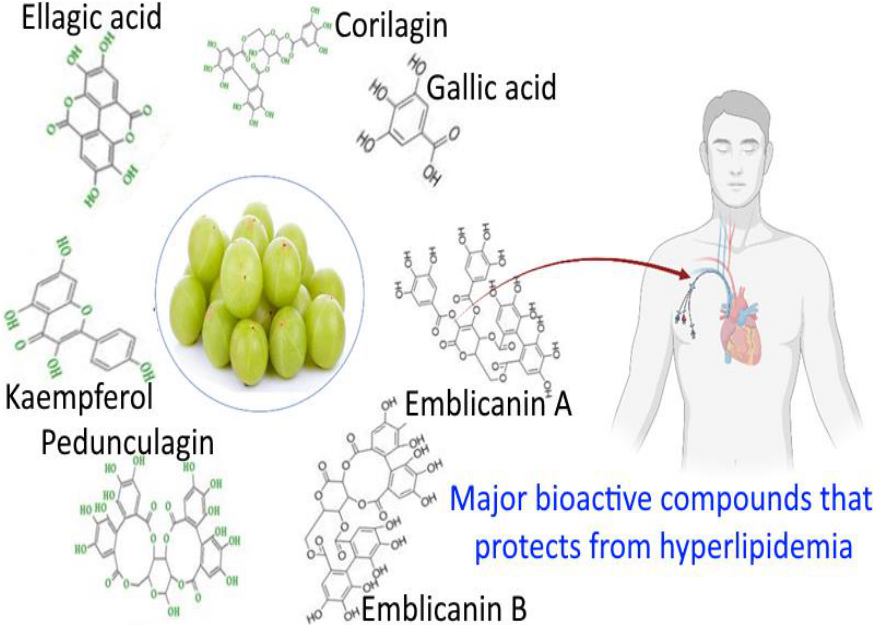
Figure 1. Major phytochemical constituents of E. officinalis that protect from hyperlipidemia.